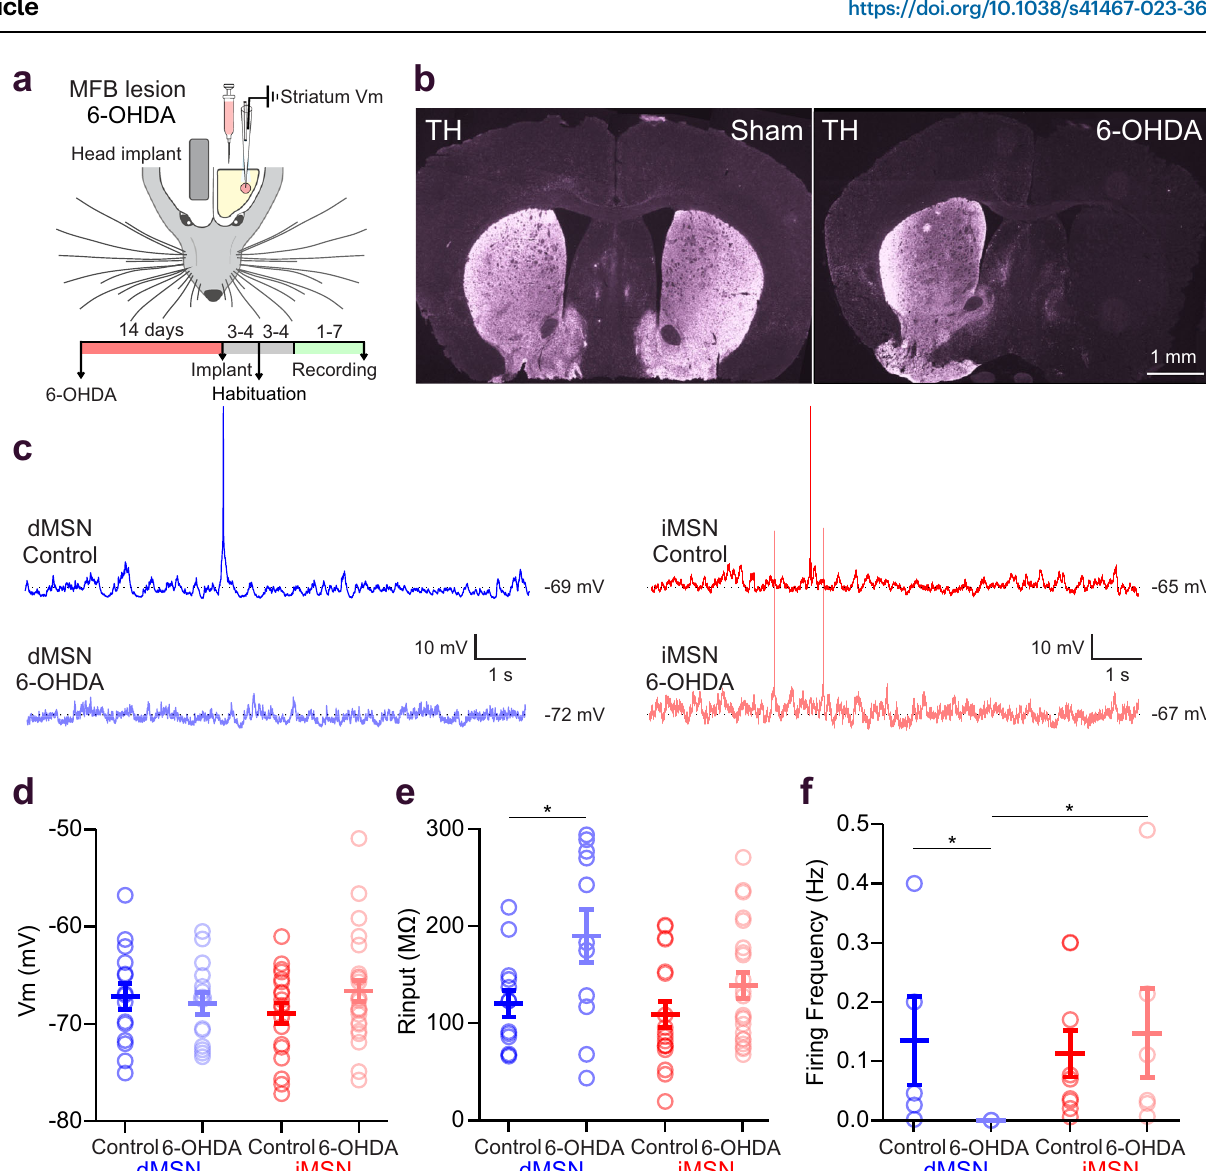
189.96±27.47 M Ω , n =11 cells; * P =0.045; iMSN control vs. iMSN 6-OHDA= 138.91±13.13M Ω , n =22cells; P =0.633;dMSN6-OHDAvsiMSN6-OHDA, P =0.141, one way ANOVA, Tukey multiple comparison test between groups F =3.582, P =0.019). f Spontaneous action potential discharge frequency of dMSNs and iMSNs showed no differences in control condition (dMSN control= 0.135±0.074Hz, n =5/15cells;iMSNcontrol=0.089±0.035Hz, n =8/19cells,two- sided Mann-Whitney test, P =0.943). Following DA depletion, dMSNs did not exhibit spontaneous fi ring (0/14 cells) while iMSNs did not change their fi ring fre- quency(iMSNcontrolvsiMSN6-OHDA=0.147±0.075Hz, n =6/25cells,two-sided Mann-Whitneytest, P =0.754).Spontaneous fi ringproportionsfordMSNcontrolvs dMSN6-OHDA,two-sided Fisher ’ s test, * P =0.042; iMSNcontrol vs iMSN 6-OHDA, two-sided Fisher ’ s test, P =0.539; dMSN 6-OHDA vs iMSN 6-OHDA, two-sided Fisher ’ s test,* P =0.035. ControldMSNs arein dark blue, control iMSNs are indark red, 6-OHDA lesioned dMSNs are in light blue, and 6-OHDA lesioned iMSNs are in light red. For all panels, data are presented as mean±SEM. Source data are pro- vided as a Source Data fi le. MFB medial forebrain bundle.